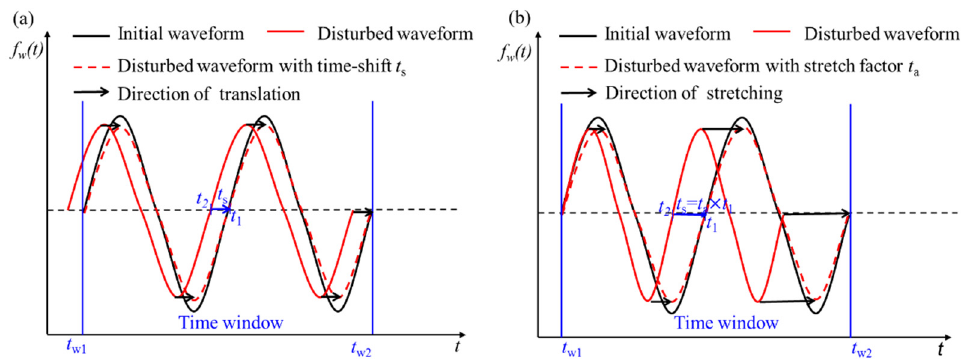
Figure 3. The method to obtain time-shift with translating ( a ) or stretching ( b ) the disturbed waveform on the time axis.